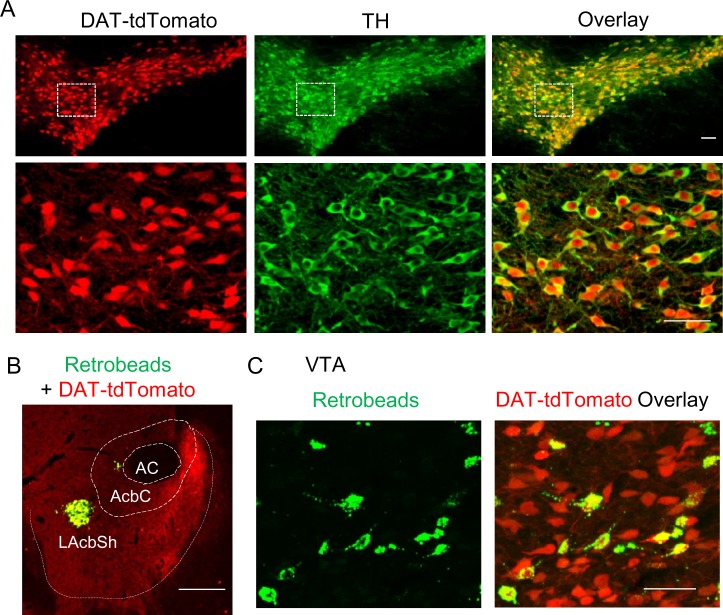
Retrobead labeling of VTA dopamine neurons that project to the lateral shell of the NAc.(A) DAT-Cre mice were bred with Ai9 reporter mice, which express tdTomato in the presence of Cre, to produce DAT-tdTomato mice. TdTomato and TH (green) were completely co-localized, indicating that tdTomato expression provides faithful reporting of dopamine neurons for slice physiology. (B) Green Retrobeads were injected into the lateral shell of the NAc (LAcbSh) in DAT-tdTomato mice. (C) The Retrobeads were retrogradely transported to the VTA and were predominantly co-localized with tdTomato-positive VTA dopamine neurons.